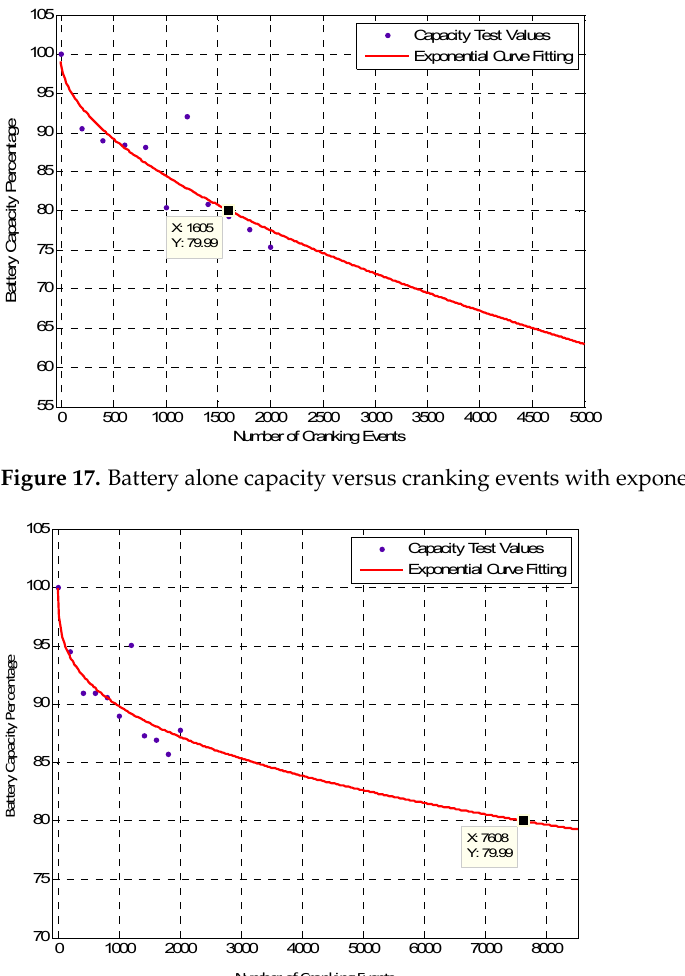
Figure 18. Hybrid battery capacity versus cranking events with exponential extrapolation.